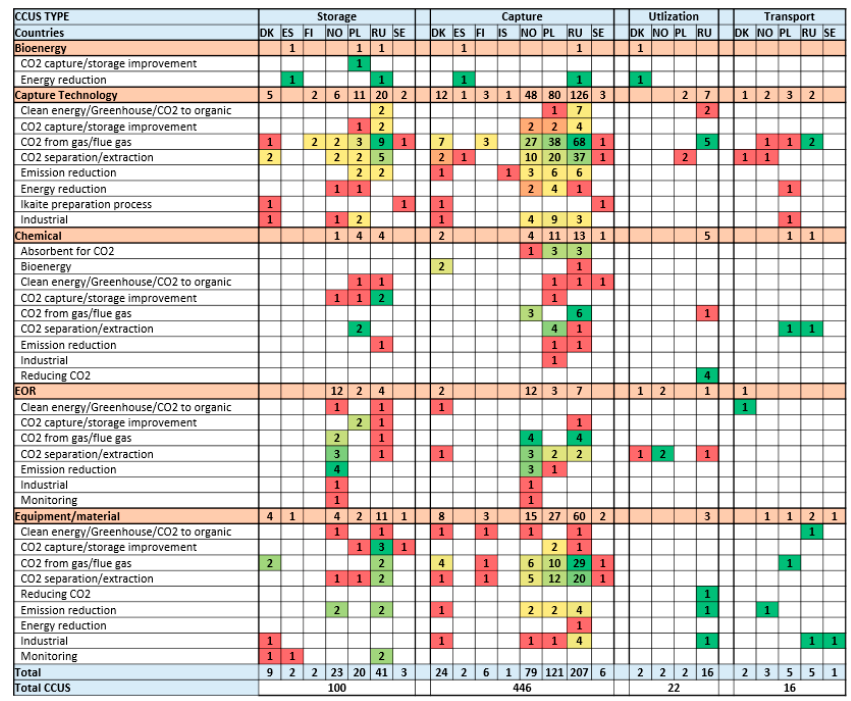
Figure 15. Technology focus (secondary)—countries. The figure uses two colors to represent high and low numbers i.e., the more green represents a higher number and more red indicates a lower figure in each of CCUS types and technology.